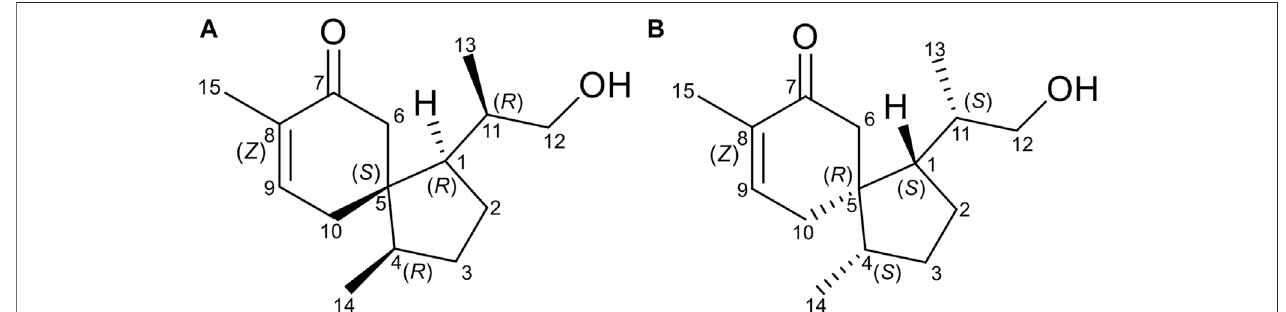
FIGURE 4 | Two possible enantiomers of compound 1 [ (A) (1 R ,4 R ,5 S ,11 R ) and (B) (1 S ,4 S ,5 R ,11 S )].